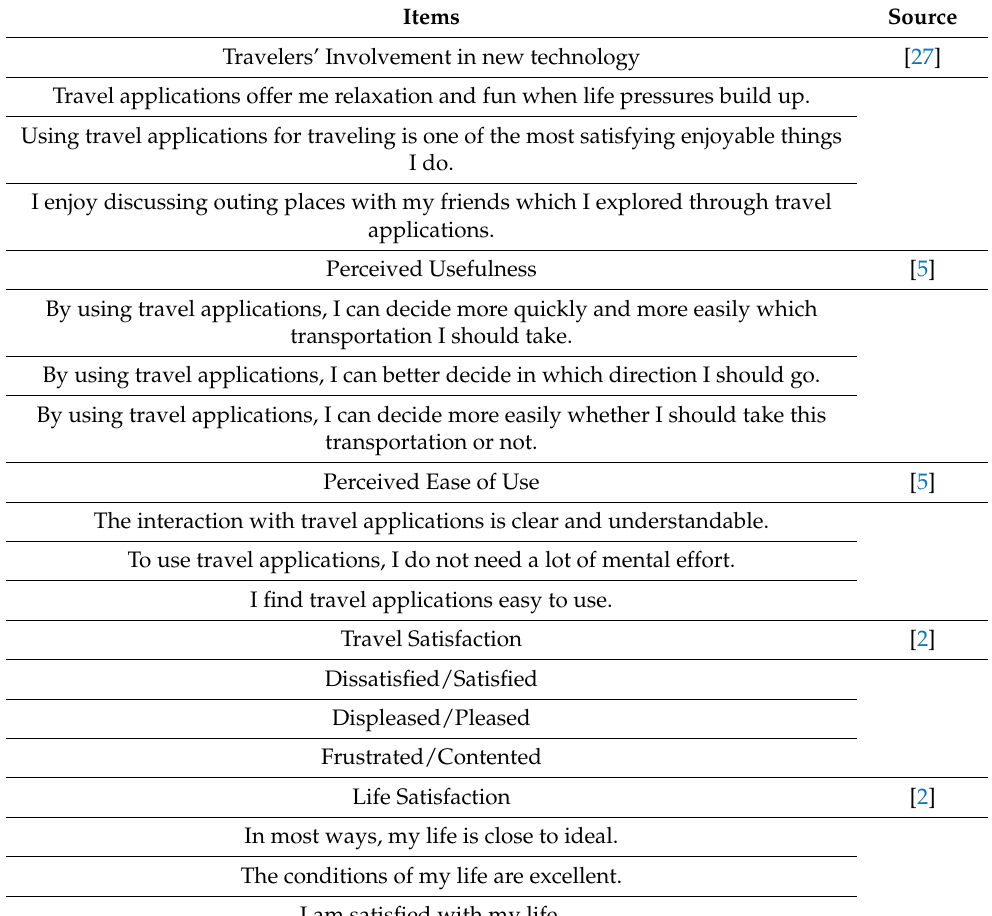
Table A1. Items drawn from literature and modified for this study.